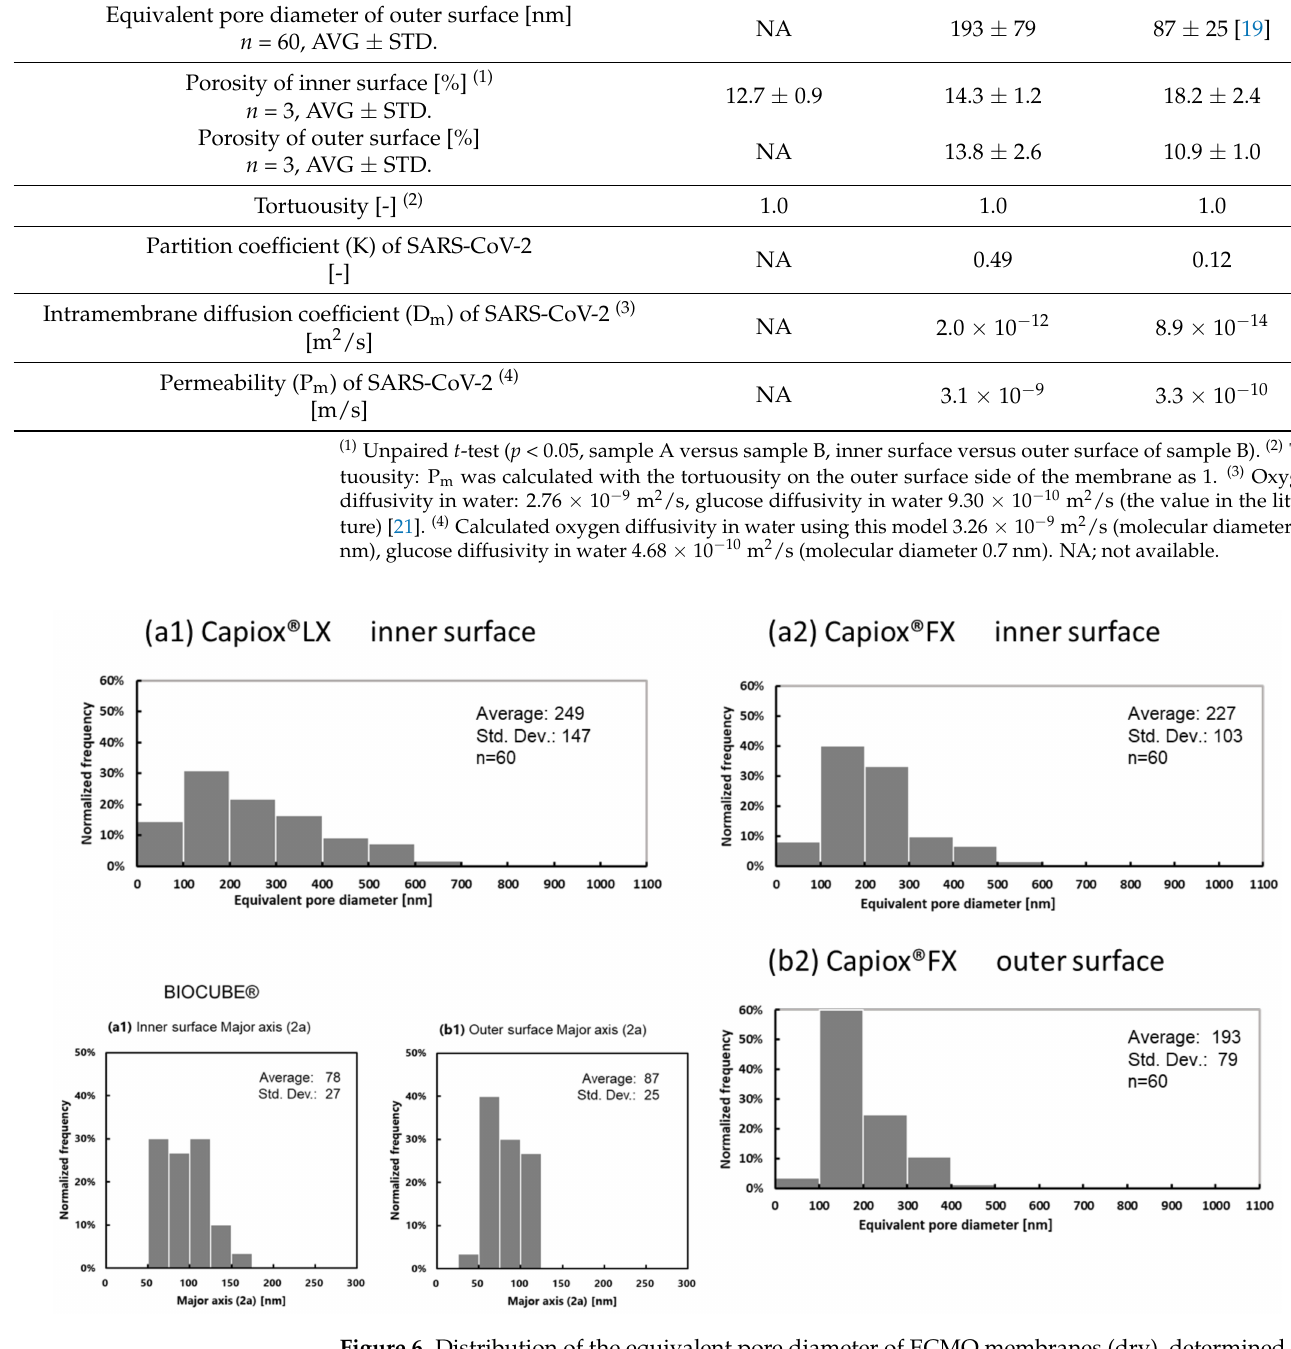
Figure 6. Distribution of the equivalent pore diameter of ECMO membranes (dry), determined via FE-SEM, ( a ) the surface of the inner lumen of the capillary membranes, ( b ) the outer surface of the capillary membranes, respectively. ( 1 ) Capiox ® LX, (2) Capiox ® FX and BIOCUBE ®